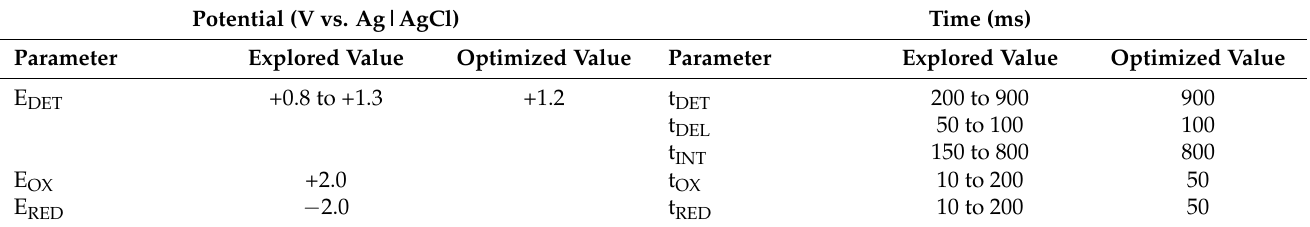
Table 1. Optimized potential-time parameters of the triple-step PAD